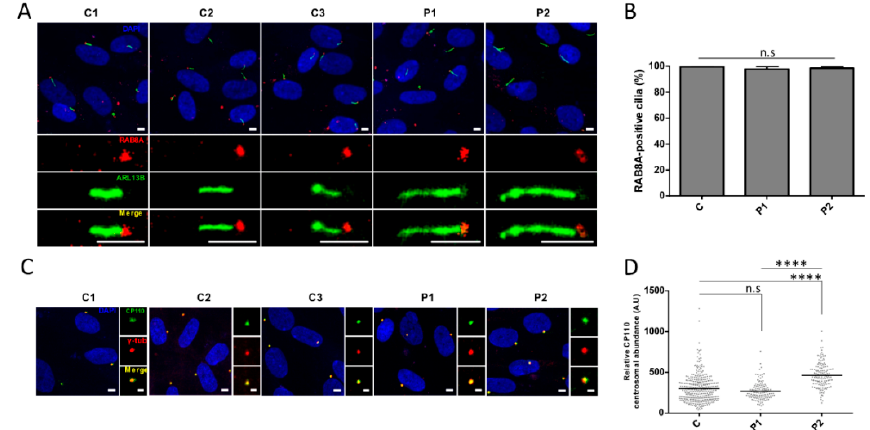
Figure 4. Localization and abundance of CEP290 centriolar satellite partners. ( A ) Representative images of RAB8A (red) localization in the cilia from control (C1–C3) and mutant (P1 and P2) fibroblasts induced to quiescence. ARL13B (green) labeling is used to mark the ciliary membrane. Scale bar, 5 µ m. ( B ) Quantification of RAB8A-positive cilia in each cell line (C represents the pooled values of C1–C3). Bars correspond to the mean ± SEM ( n ≥ 50 cilia for each group). n.s = not significant. A.U. = arbitrary unit. ( C ) Representative images of CP110 (green) centrosomal staining in quiescent control and mutant fibroblasts. Centrosomes are stained by γ -tubulin ( γ -tub.; red). Image scale bar, 5 µ m and inset scale bar, 2 µ m. ( D ) Quantification of CP110 immunofluorescence intensity at centrosomes in quiescent fibroblasts (C represents the pooled values of C1–C3). Each dot depicts the labeling intensity of the protein in individual cells from six microscope fields (recorded automatically). The solid line indicates the mean. **** p ≤ 0.0001, n.s = not significant. A.U. = arbitrary unit.